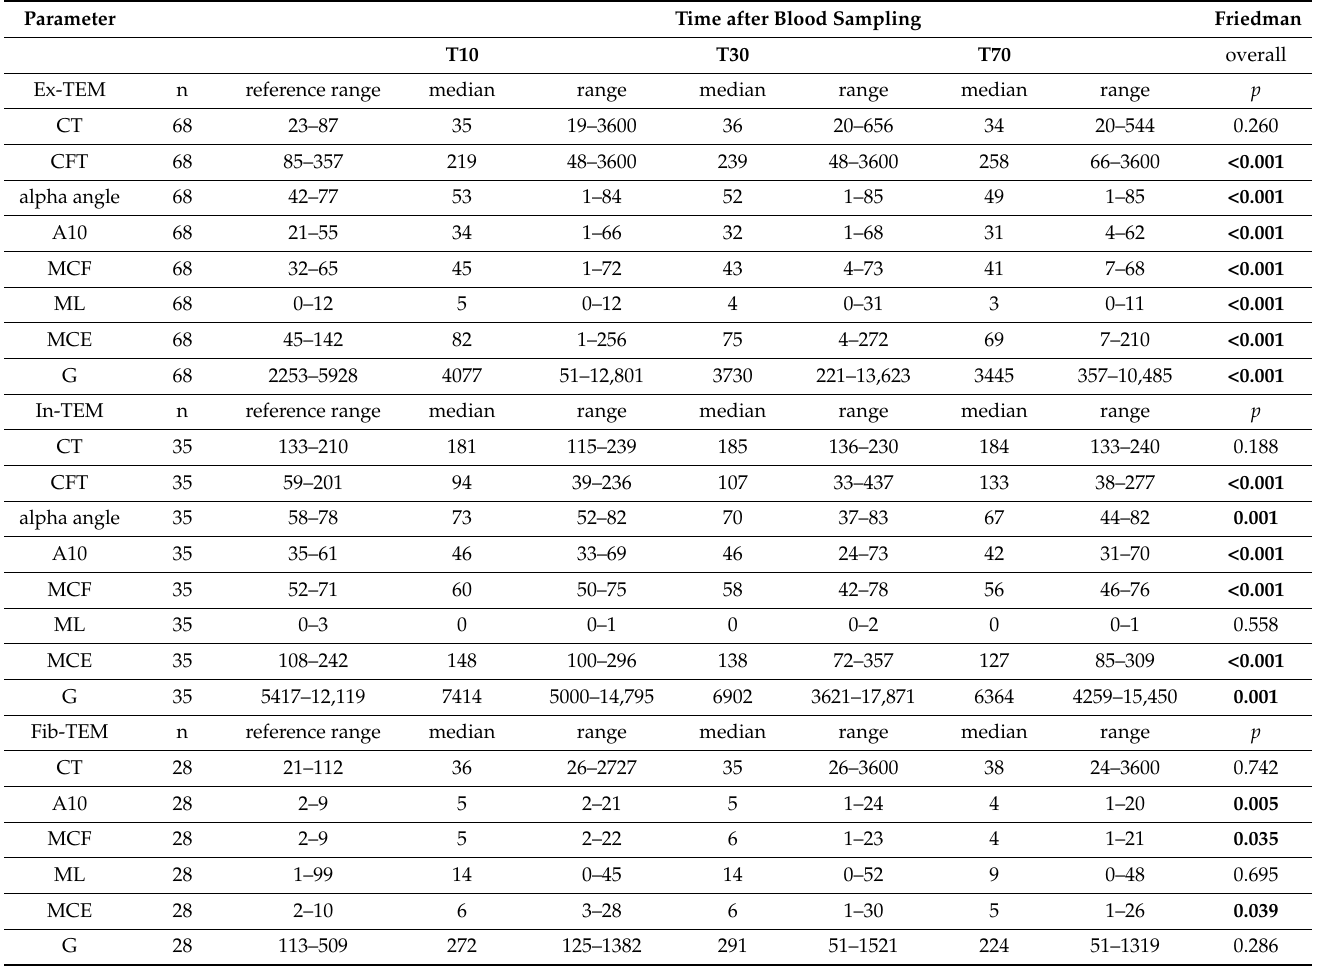
Table 1. Ex-TEM, In-TEM, and Fib-TEM parameters over